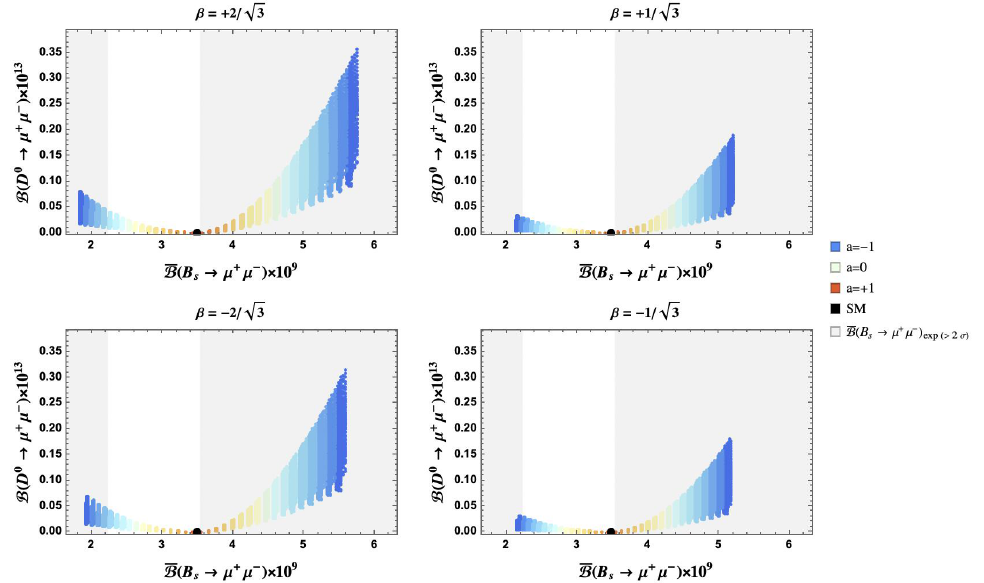
as in figure 8. The black dot represents the SM result. The shaded gray areas correspond to regions excluded by the average of the experimental measurements of B ( B